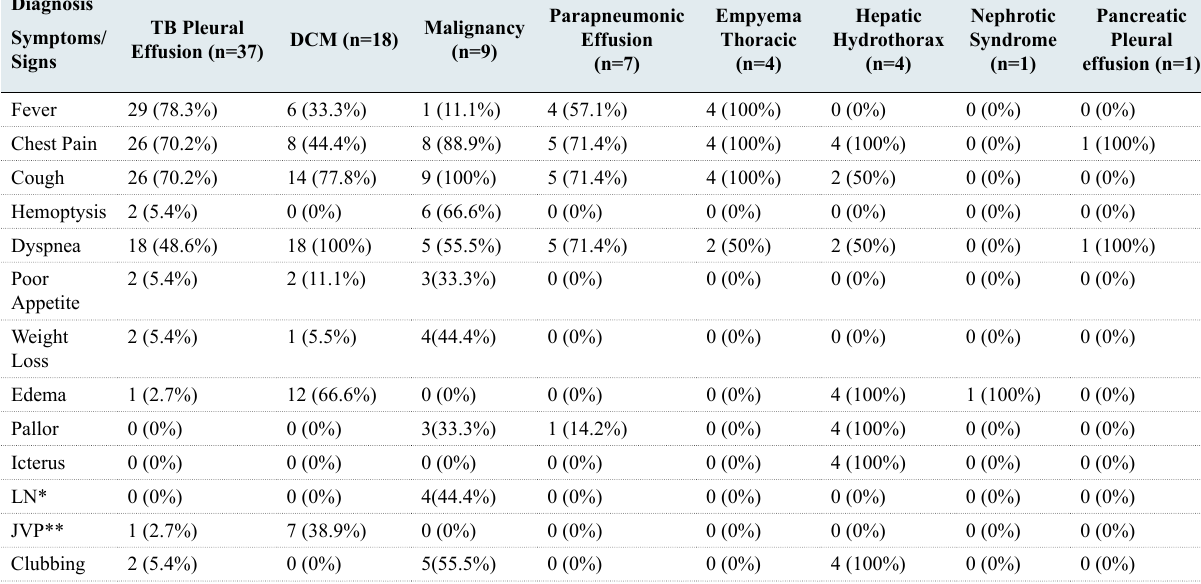
Table 1: Major presenting symptoms/signs in different diagnosis on the discharge of the study population Diagnosis TB Pleural Effusion (n=37)